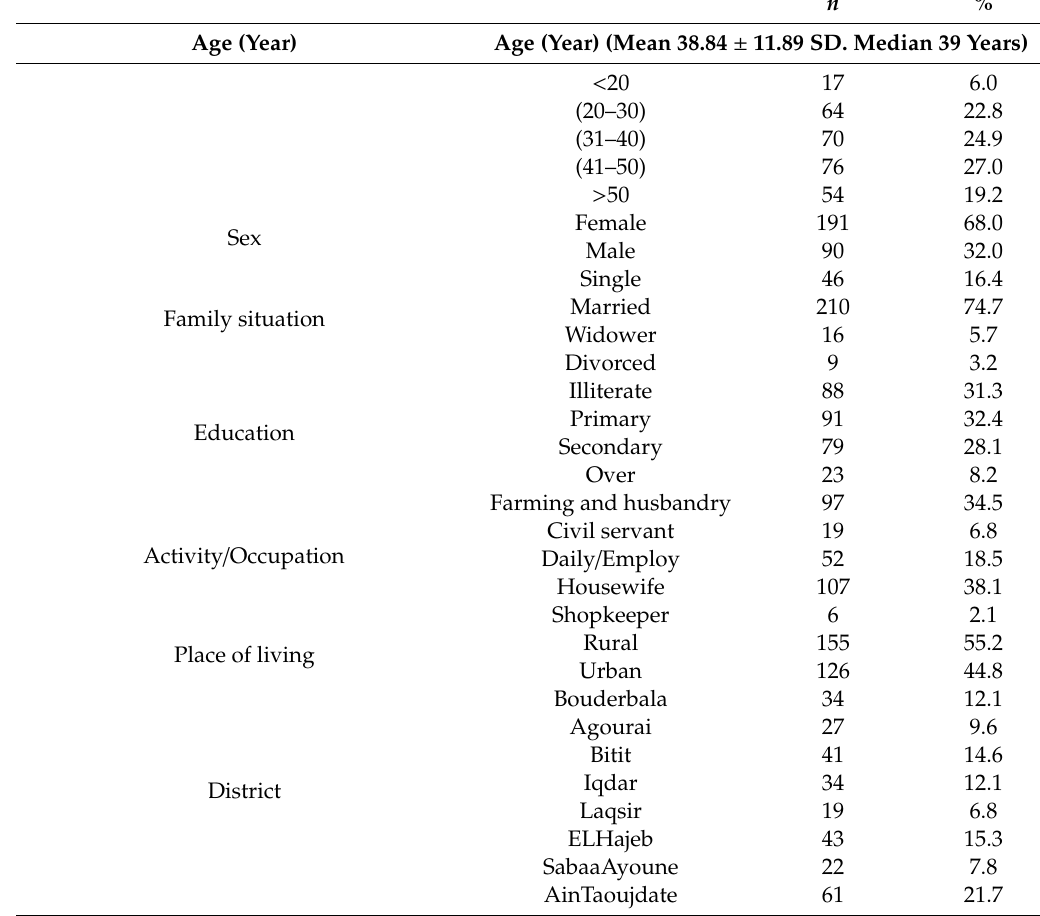
Table 4. The socio-demographic characteristics of the inhabitants, their levels of knowledge and their attitudes towards sand